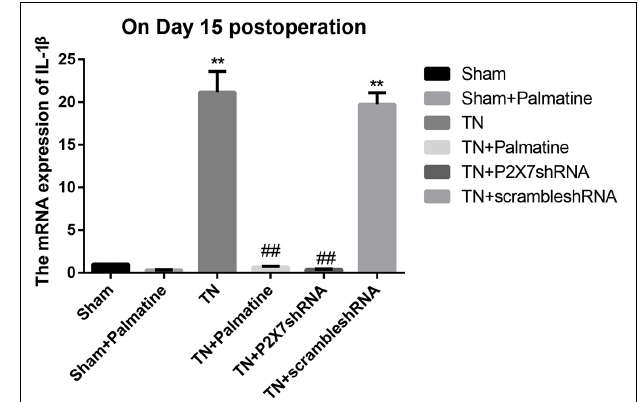
FIGURE 3 | IL-1 β mRNA expression in TGs of each group detected by qRT-PCR on fifteen days after operation. Values are mean ± SD, n = 6,